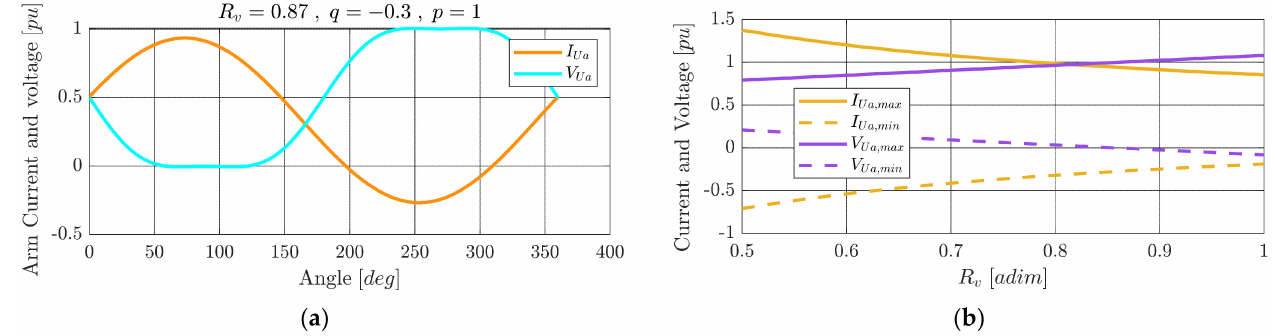
Figure 11. Upper a arm current and voltage waveforms at p = 1, q = − 0.3, R v = 0.866 ( a ); max and min arm voltage and current ( b